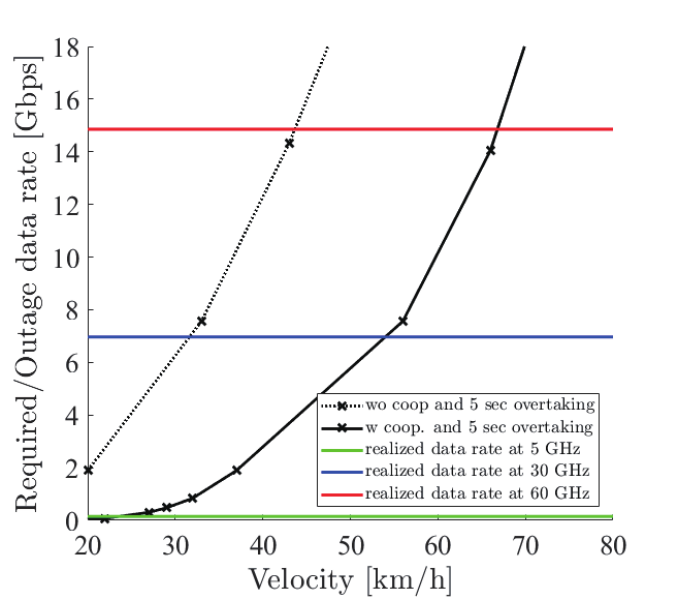
Figure 20. Required data rate and 0.01% outage data rate realized by the 5, 30 and 60 GHz bands under d be = 15 m.